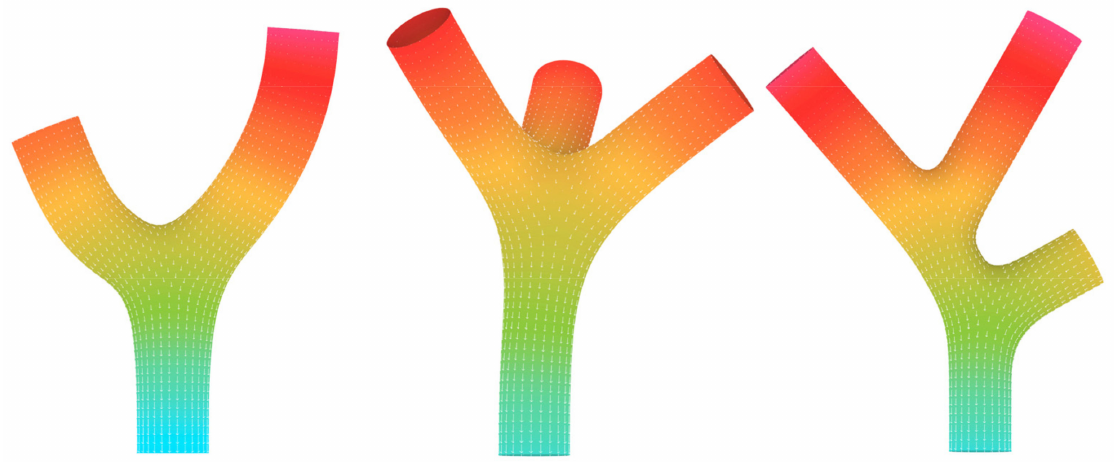
Figure 4. Temperature field of three